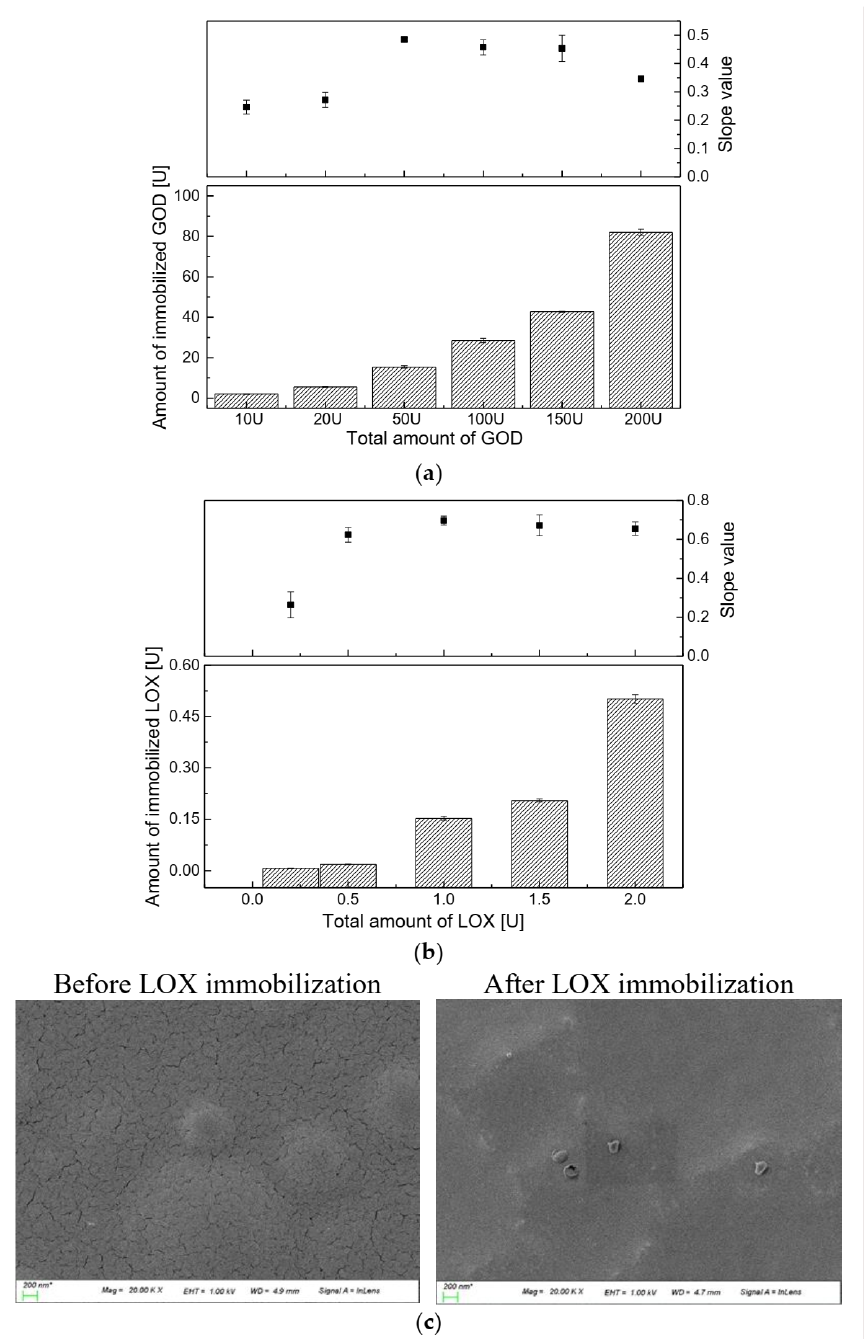
Figure 3. ( a ) Immobilization efficiency of different amounts of GOD, and slope values of the calibra- tion curves of the glucose-sensing membranes in the glucose concentration range from 0 to 2 mM; ( b ) immobilization efficiency of different amounts of LOX, and slope values of the calibration curves of the lactate-sensing membranes in the lactate concentration range from 0 to 0.8 mM; ( c ) SEM images of the oxygen-sensing membrane before and after LOX